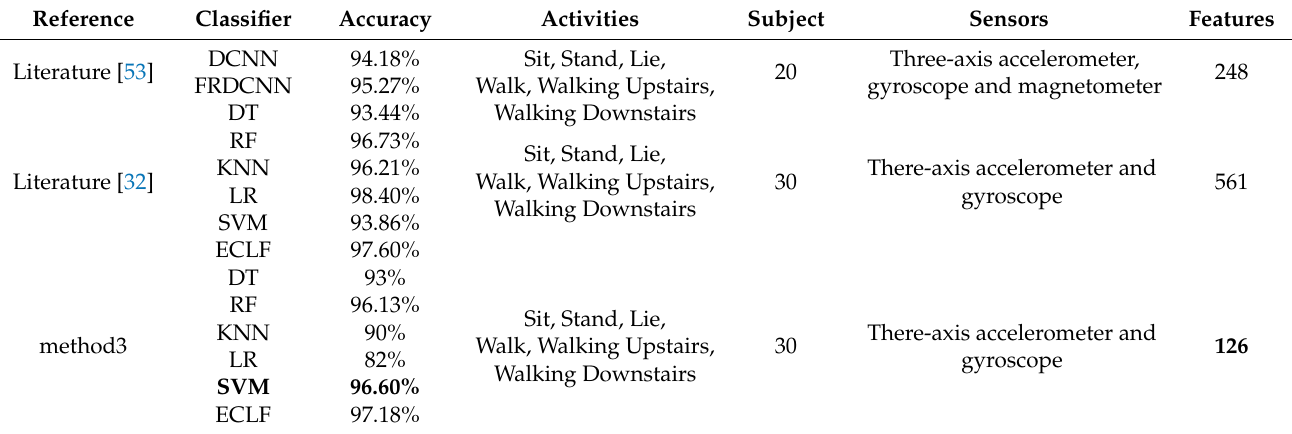
Table 3. Comparison of classification accuracy for basic actions using different methods.